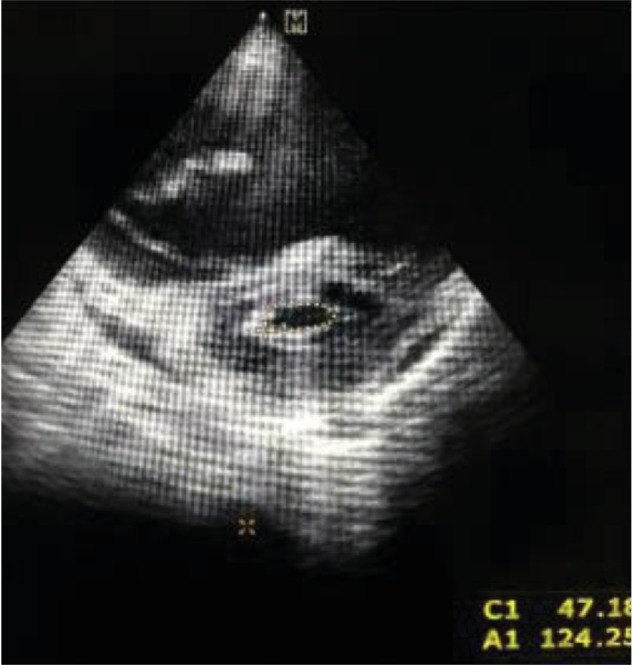
2D echocardiogram-guided planimetry showing MVA is 1.24 cm2.